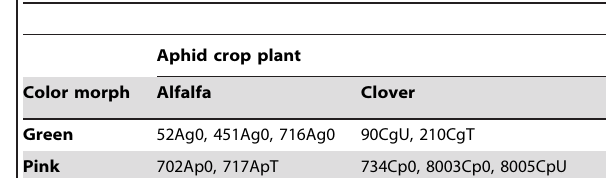
Table 1. Experimental aphid clones classified by source crop plant, aphid color morph and screened symbiotic